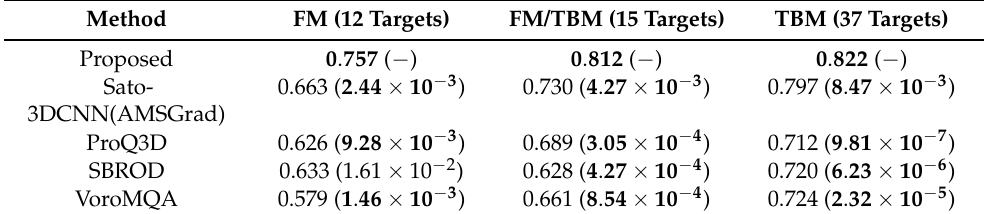
Table A4. The average Pearson correlation coefficient for each category of targets on CASP13 dataset.